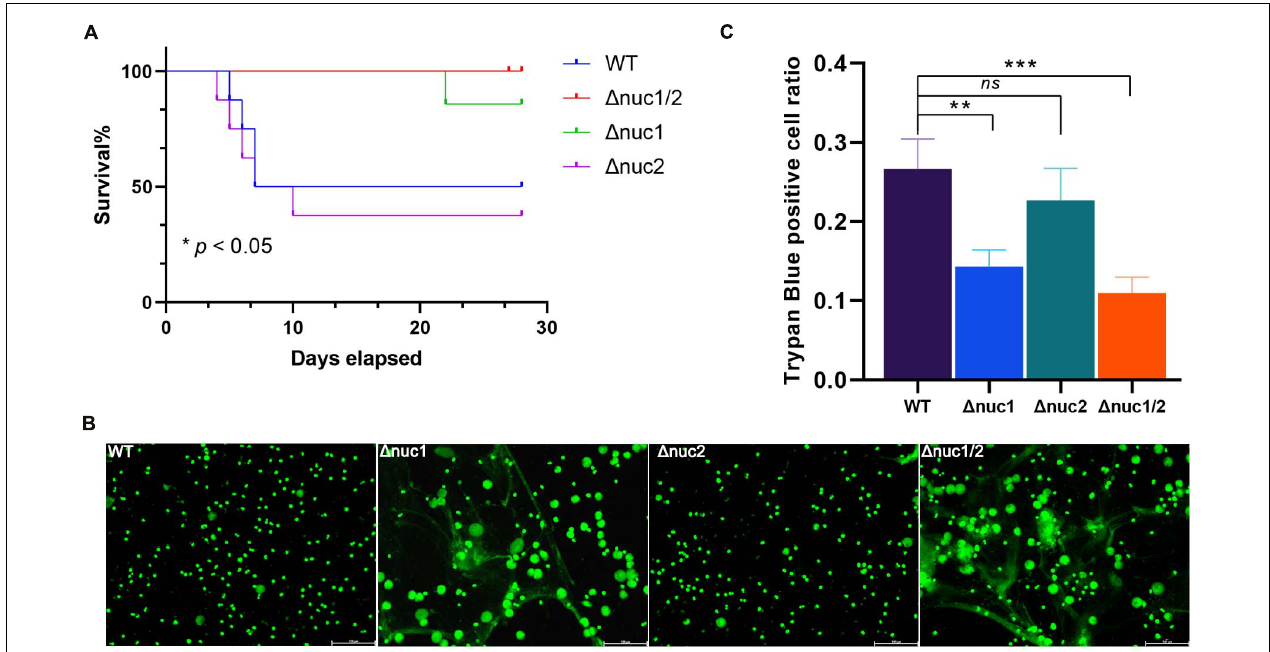
FIGURE 6 | nuc1 and nuc2 involvement in immune evasion. (A) Survival curve for a hematogenous IAI mouse model infected with ST1792 WT, (cid:49) nuc2 ( n = 8 each), and (cid:49) nuc1 and (cid:49) nuc1/2 ( n = 7 each). (B) Representative fluorescent images for NET degradation assay. S. aureus were incubated with PMA-stimulated neutrophils ( n = 3/group). A green signal represents NETs and cell nucleus, scale bar = 100 µ m. (C) THP-1 macrophages were incubated with DNA and S. aureus . Cell viability was determined by trypan blue staining ( n = 3/group). The survival curve was analyzed with a log-rank (Mantel–Cox) test. ANOVA with Dunnett multiple column comparisons was used in panel (C) . ** p < 0.01; *** p < 0.001 vs.